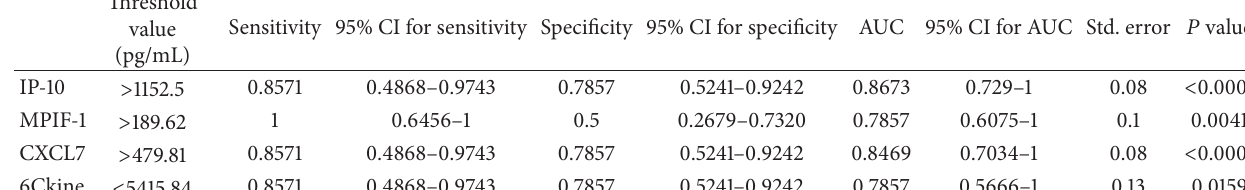
Table 5: Diagnostic values of chemokines in amniotic